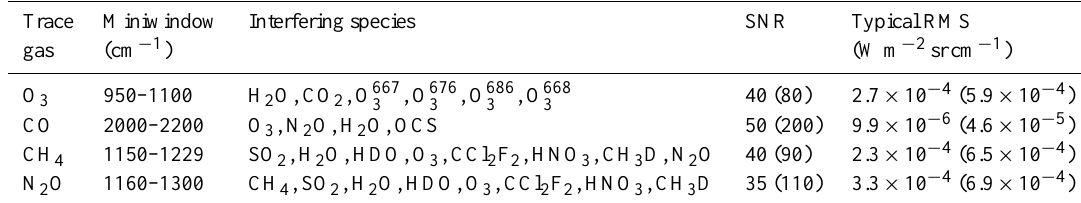
Table 1. Retrieval specifications for each target trace gas: the retrieval miniwindow (spectral range), interfering species scale fitted in each miniwindow, SNR, and typical RMS residual of the spectral fit for spectra measured in December